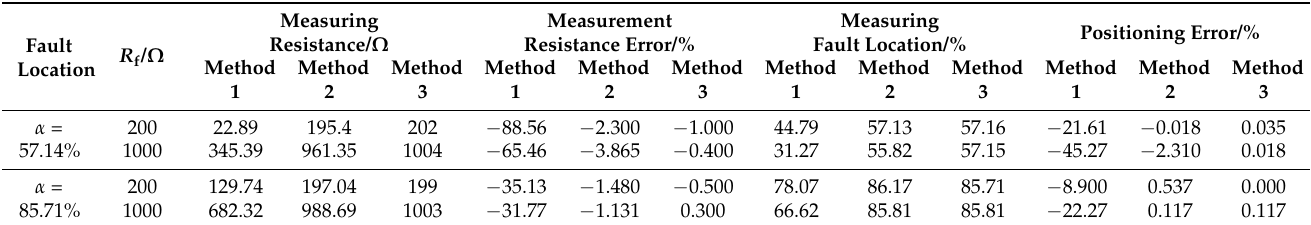
Table 5. Comparison of fault location errors with different